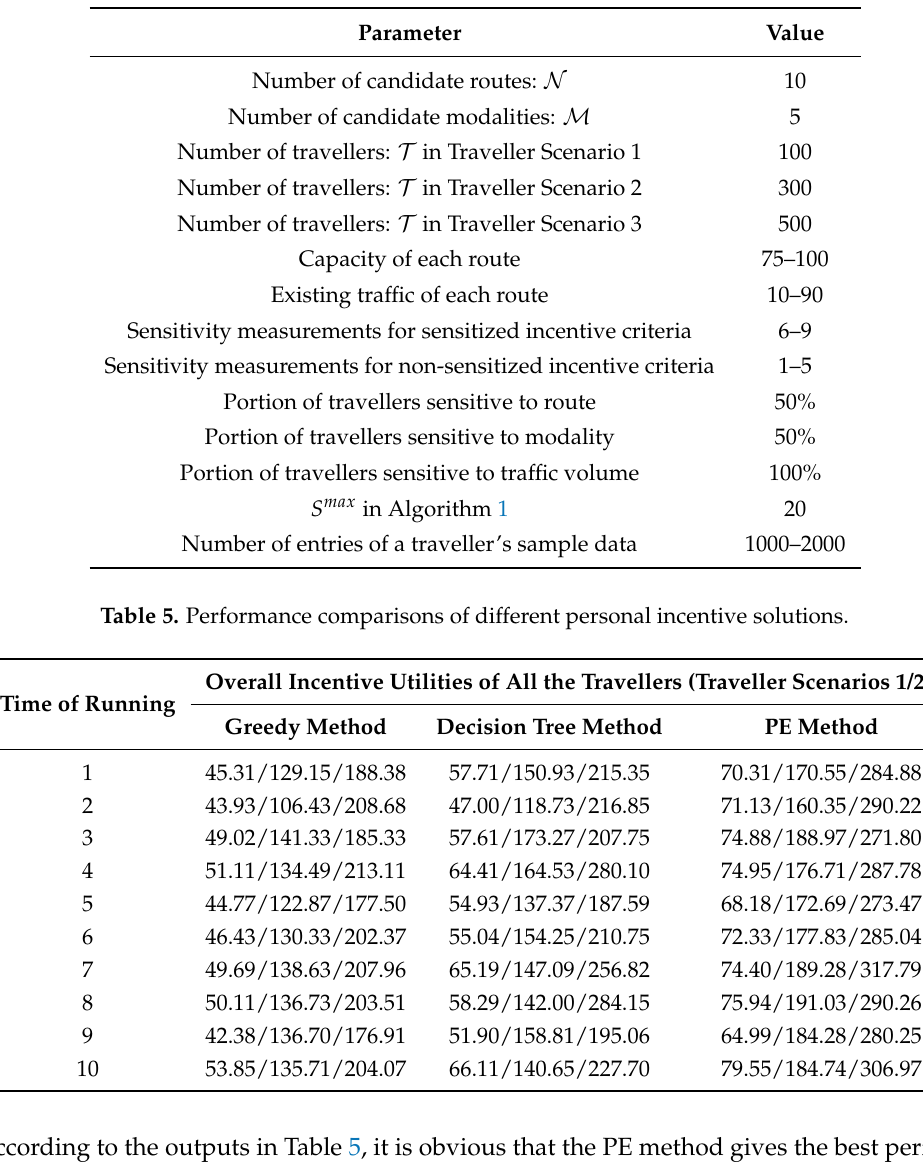
Table 4. Configurations for the simulation validation.